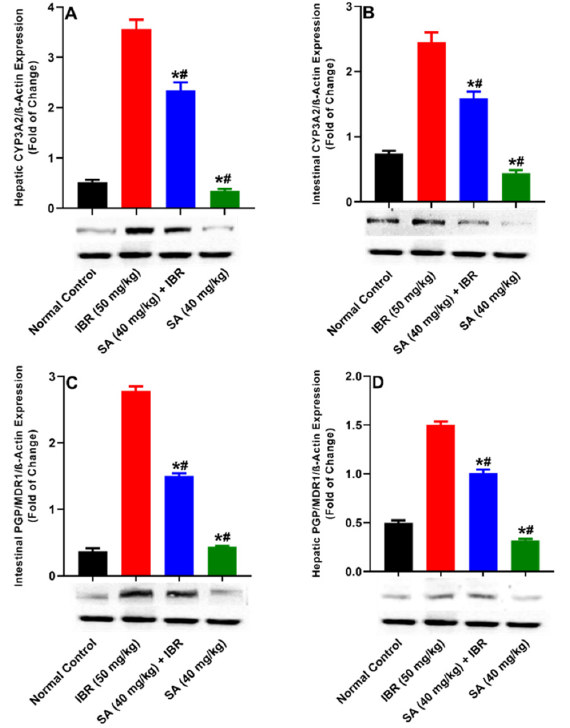
Figure 2. Hepatic CYP3A2 ( A ) and Pgp glycoprotein/MDR1 ( D ) and intestinal CYP3A2 ( B ) and Pgp glycoprotein/MDR1 ( C ) protein expression in rats after IBR administration with or without sinapic acid (SA) pretreatment. All results are presented as the average ± SEM. * p < 0.05 (control); # p < 0.05